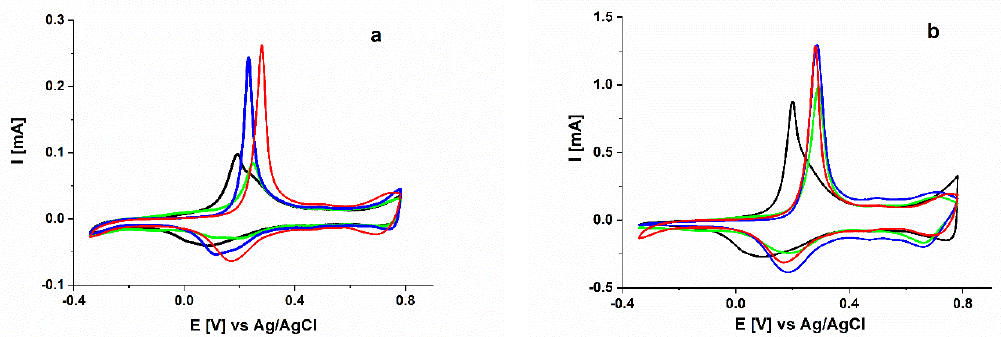
Figure 6. Voltammetric scans measured in 0.5 M H 2 SO 4 after XPS studies and long-term storage in the dry state of thin ( a ) and thick ( b ) PANI layers obtained in the presence of PAMPSA (black), t-PASA (blue), i-PASA (red) and PSSA (green).